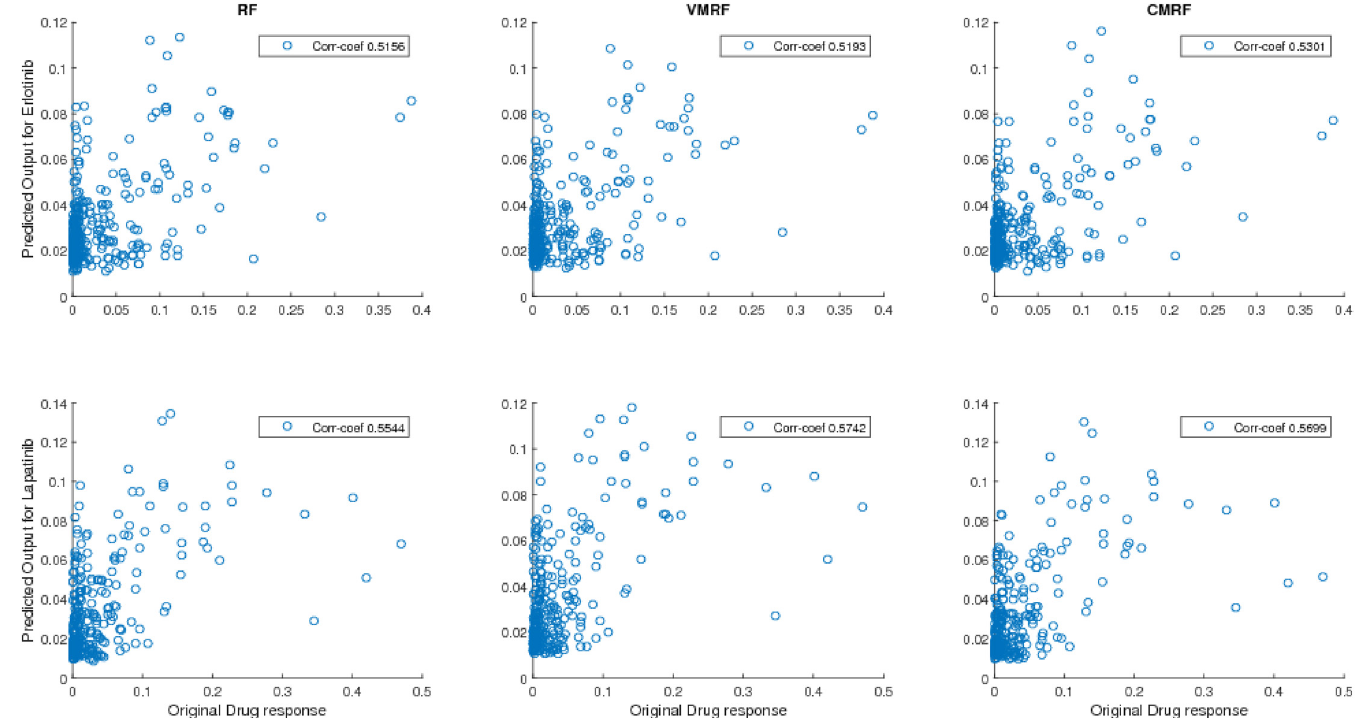
Fig 7. Scatter plots of predicted response vs original response for Erlotinib and Lapatinib (GDSC). Here corr-coef stands for correlation coefficient between predicted response and output